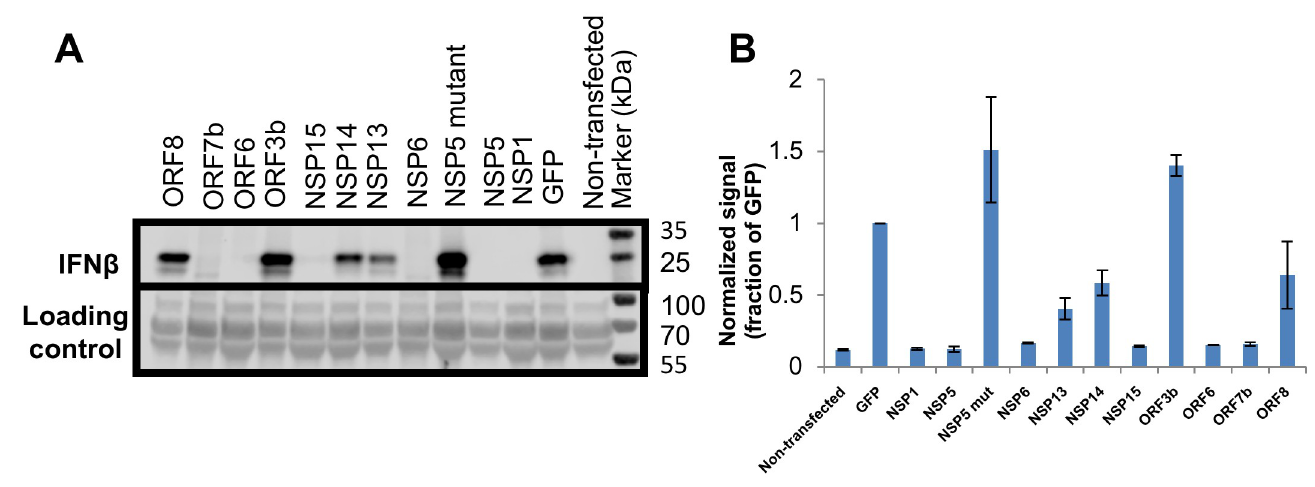
Fig 5. Suppression of MAVS induced IFN β protein secretion by SARS-COV-2 genes. (A). Upper panel: HEK-293T cells were transfected with MAVS and a viral gene. 48 hours post transfection secreted proteins were collected and analyzed by western blot, using an antibody specific to human IFN β . Lower panel: The transfer membrane was stained with Ponceau S, this which served as a sample loading control. (B). Quantitative analysis of (A) (average of two independent experiments ± SEM).